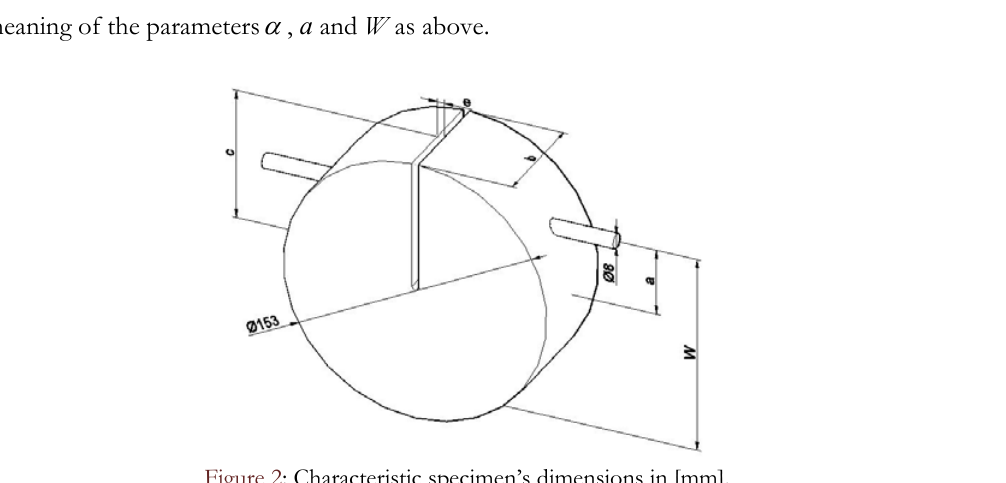
Figure 2: Characteristic specimen’s dimensions in [mm].